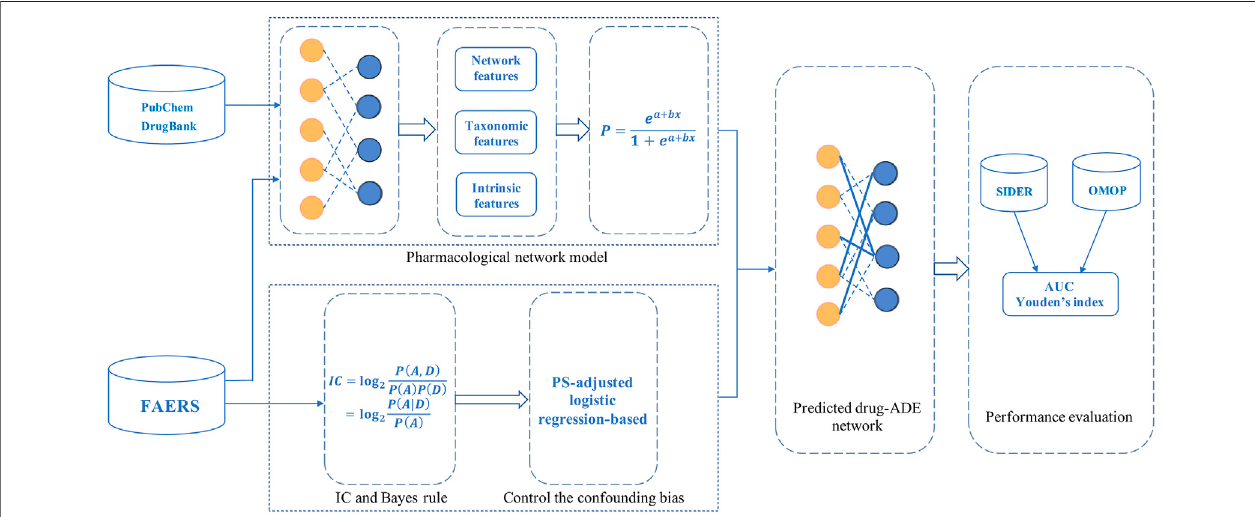
FIGURE 1 | Overall framework, performance evaluation, and thus generating enhanced drug-ADE signals using a Bayesian signal detection algorithm based on pharmacological network model (IC PNM ).